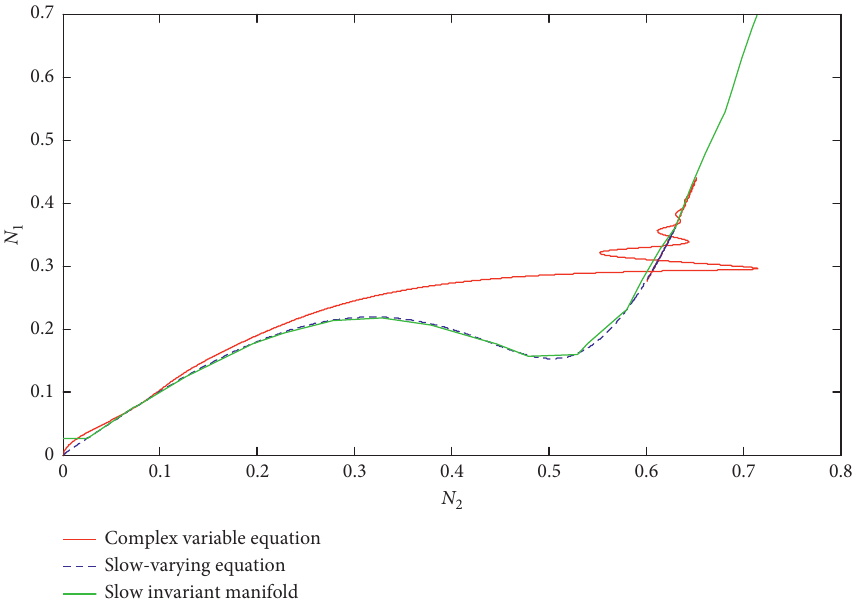
� 0 . 8 ; λ � 0 . 3 ; kn � 5 ; f � 0 . 25. 1 2